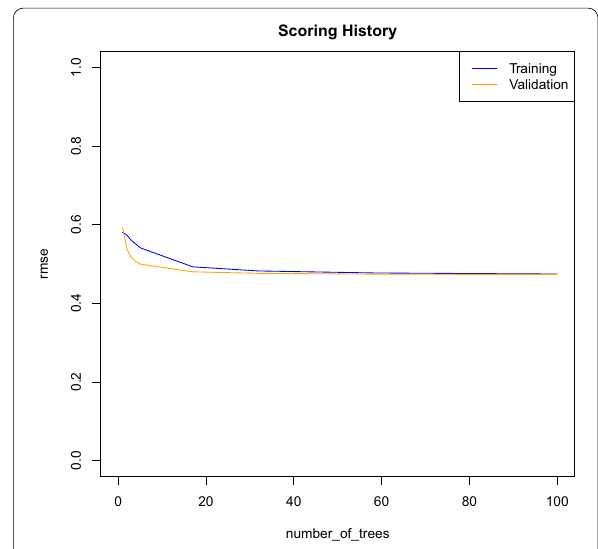
Fig. 1 Error Rate, given by the root-mean-square error (rmse) versus number of Trees—Output of the Random Forest